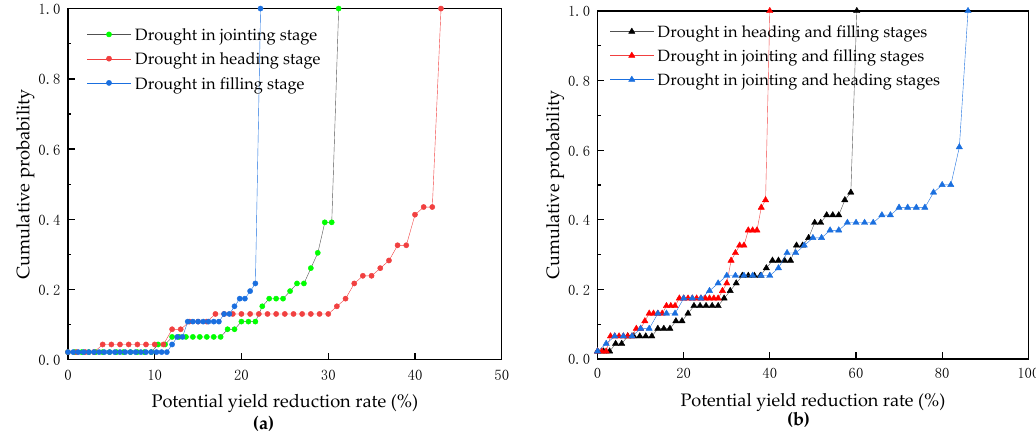
Figure 10. Frequency distribution of potential yield reduction rate at different growth stages of summer maize from 1970 to 2015.